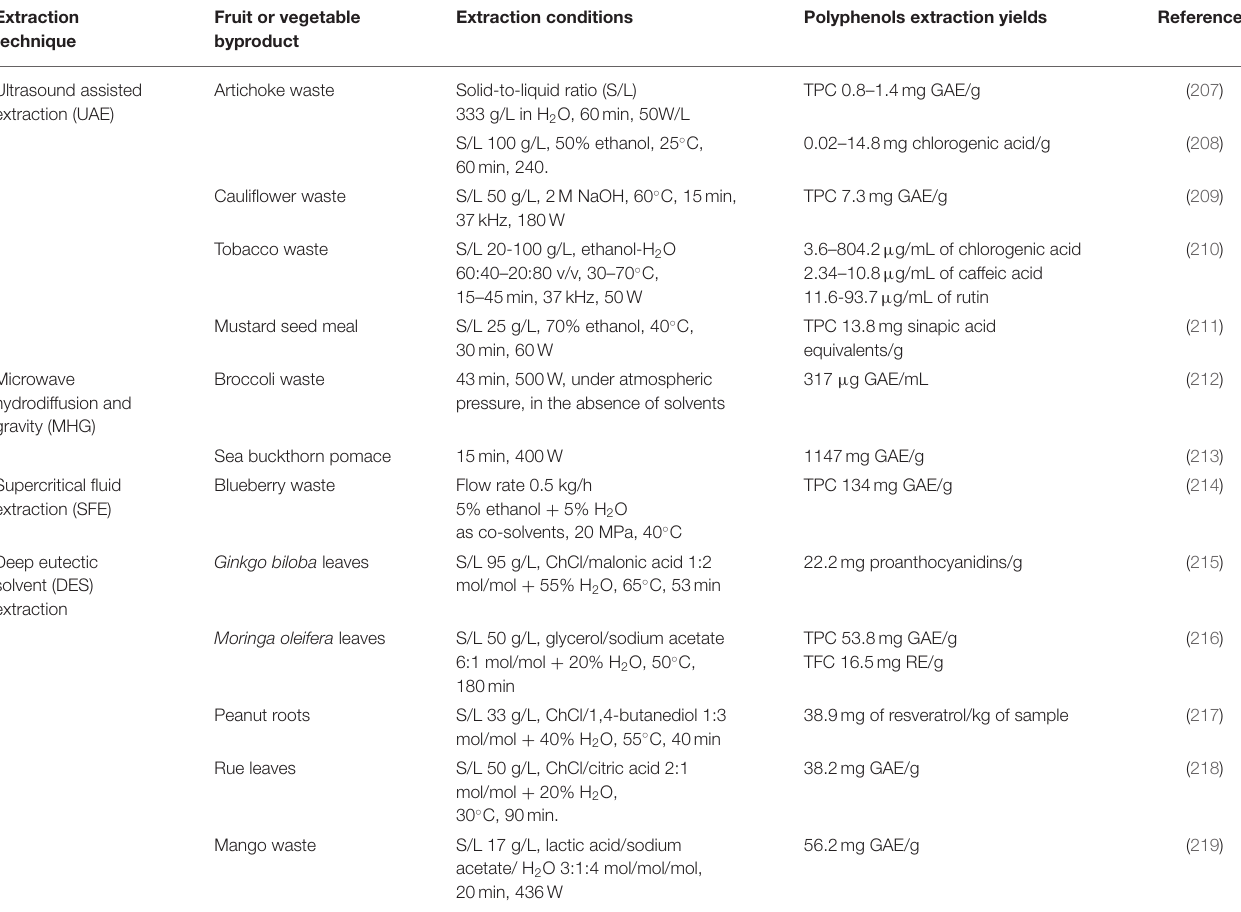
TABLE 3 | UAE, SFE, MHG, and DES extraction of phenolic compounds from various agri-food wastes. Extraction